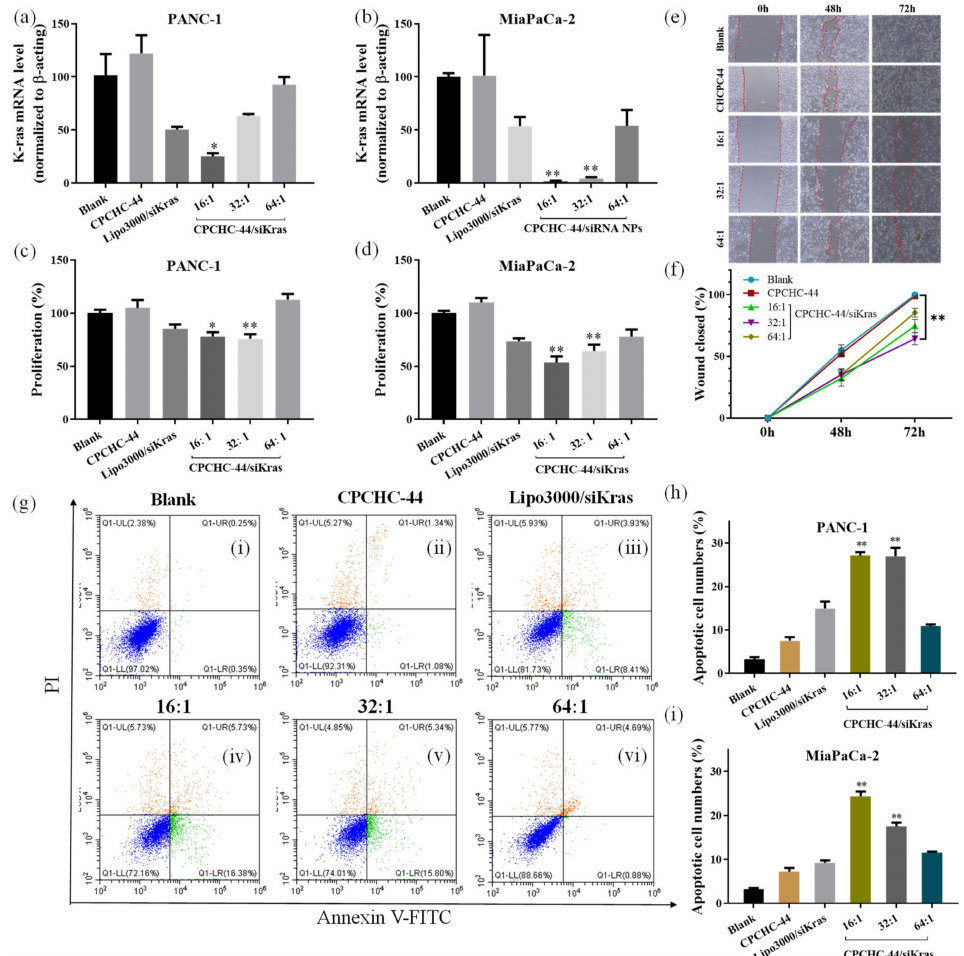
Figure 4. Anti-cancer efficacy of CPCHC-44/siRNA nanocomplex-mediated gene silencing in PANC- 1 and MiaPaCa-2 cells. Determined by real-time PCR, expression levels of siKras were acquired in the treated ( a ) PANC-1 and ( b ) MiaPaCa-2. The gene expression of each tested formulation was normalized to that of β -actin. After treatment with the tested formulations, the proliferation of the treated ( c ) PANC-1 and ( d ) MiaPaCa-2 cells was determined using a MTT assay after a cultivation time for 72 h. Untreated cells were used as the control. ( e , f ) Wound healing assay results in PANC-1 cell treated with different concentrations of CPCHC-44/siRNA NPs. ( e ) Microscopic images for the wound healing status of the treated PANC-1 cells at 0 h, 48 h, and 72 h post-treatment. ( f ) Quantitative evaluation of the percentage of wound closed area through the estimation of the Image J software. The percent values were normalized on the basis of the initial wound window width. ( g – i ) Apoptosis assay results for PANC-1 and MiaPaCa-2 cells after the treatment of the tested formulations. After the treatment for 72 h, the cells were co-stained with annexin V and propidium iodide (PI), followed by a flow cytometry measurement. ( g ) Representative pictures of cells treated with (i) blank, (ii) CPCHC- 44, (iii) Lipo3000/ siKras, and CPCHC-44/siKras NPs with various CPCHC-44/siKras weight ratios: (iv) 16:1, (v) 32:1, (vi) 64:1. ( h , i ) Apoptotic and dead cell percentages in the quadrants (Q1 + Q2 + Q4) for the cells treated with the tested formulations. Values are the mean ± SD, n = 3 (*, p < 0.05; **, p <